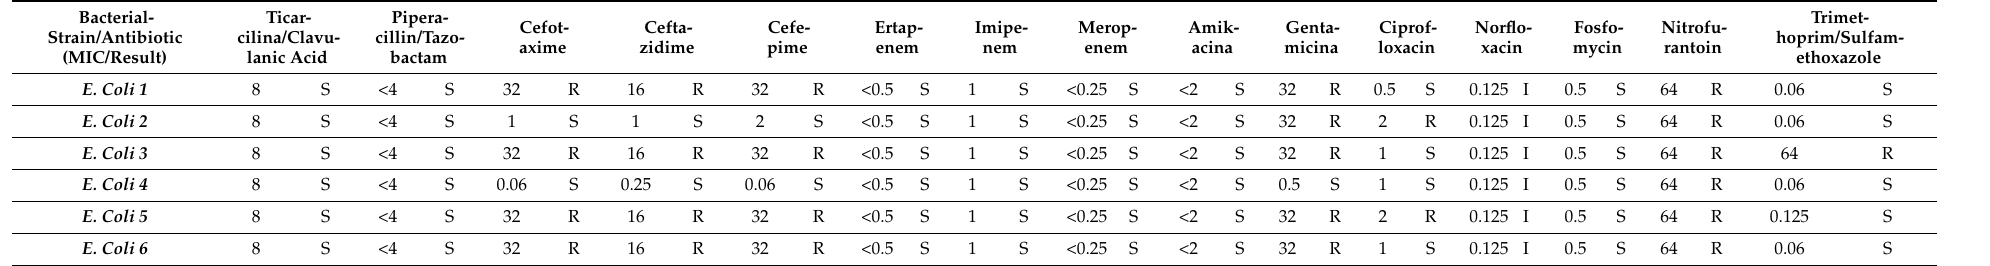
Table 7. MICs (mg/L) of antimicrobials for Escherichia coli isolates.